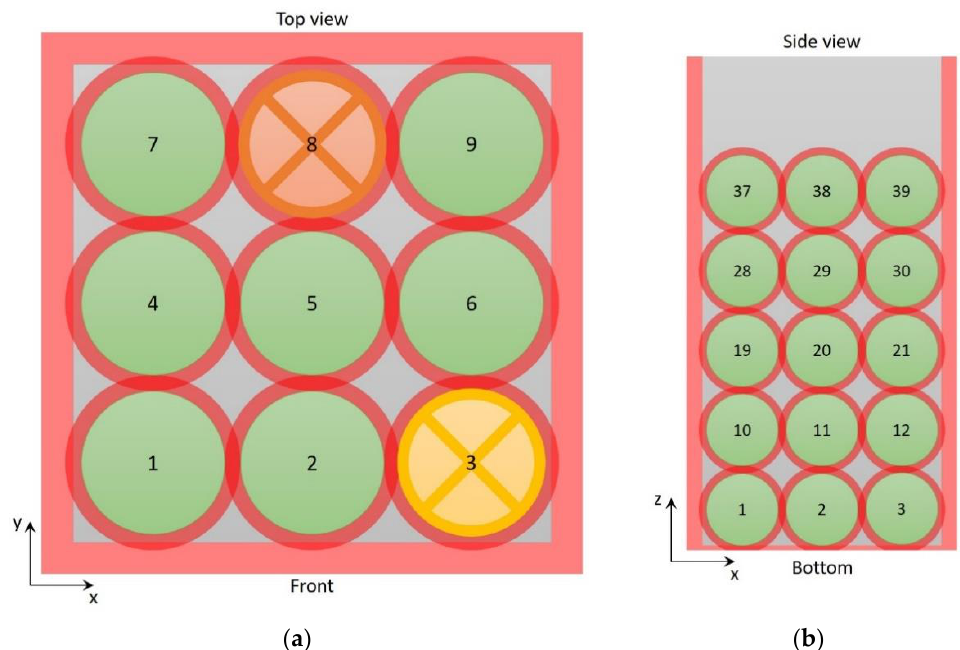
Figure 4. Numbered positions for the specimens and the positions of the “anchor” specimens. ( a ) The bottom layer of specimens numbered 1 through 9. Position 3 is reserved anchor specimens for z-layers 1, 3, and 5, while position 8 is reserved anchor specimens for all z-layers; ( b ) a front view showing the first three numbers of each layer (the front row).